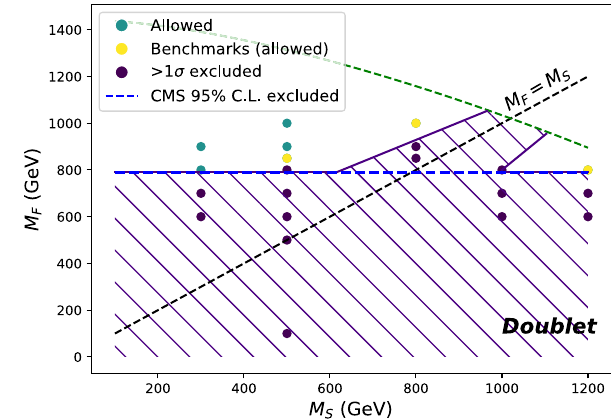
sured by CMS [24]. For benchmark points marked as yellow circles we show the L T distributions in Fig. 7. Above the green dashed curve κ (cid:4) becomes